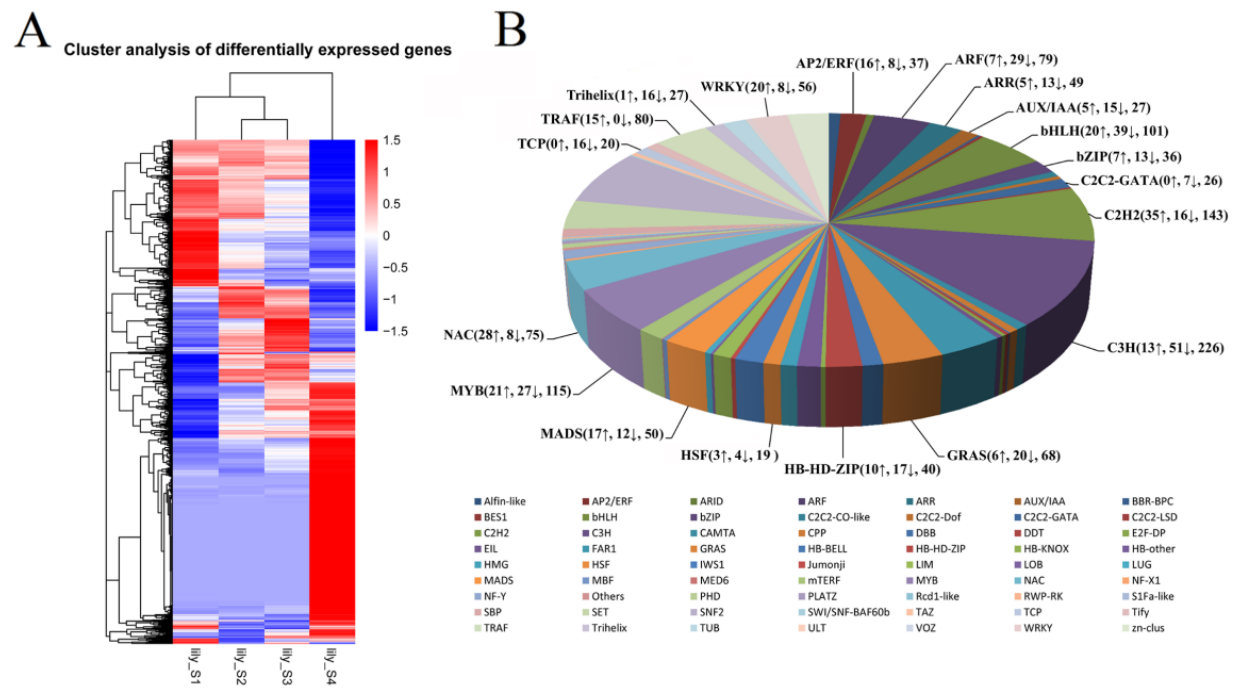
Figure 3. Cluster analysis of differentially expressed genes (DEGs) and distribution of transcription factors. ( A ) Heat map shows the expression of 20,650 DEGs in flowers of lily ( Lilium oriental ‘Siberia’) at stage 1 to stage 4; ( B ) pie chart demonstrates the distribution of transcription factors. The numbers with up arrows and down arrows mean up- and downregulated genes at stage 4 compared with the other three stages, respectively, and the last number in brackets means the total number of genes obtained through SMRT sequencing.